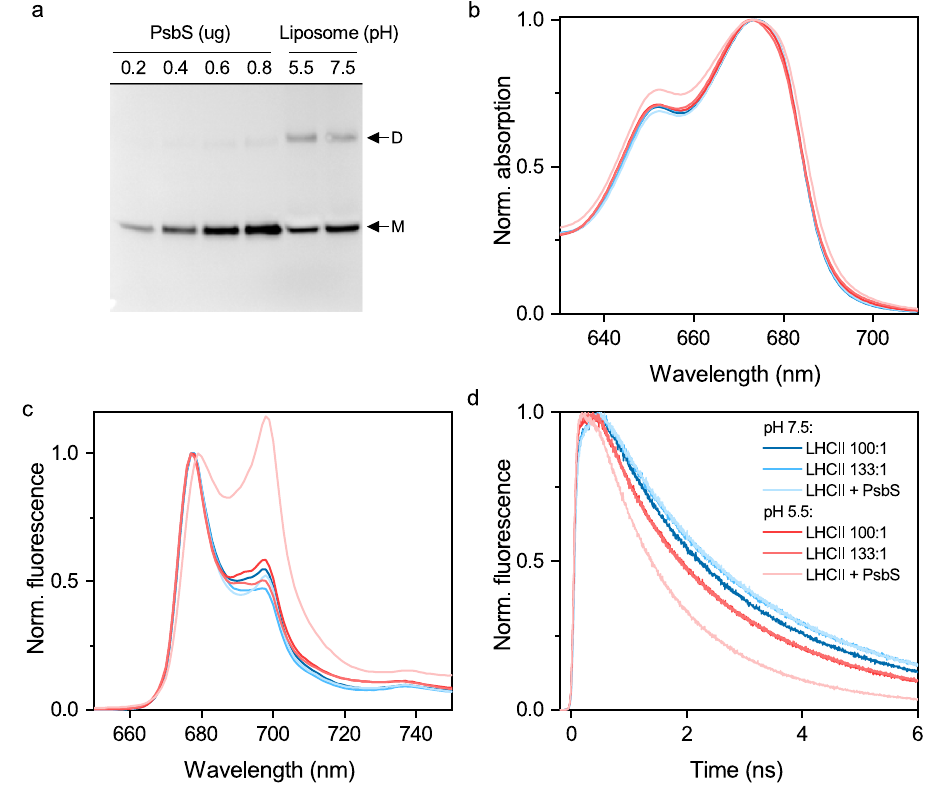
Figure 3. The effect of PsbS on LHCII spectral characteristics in the liposome at pH 7.5 and pH 5.5. ( a ) Immunoblot of PsbS in detergent and in LHCII + PsbS proteoliposomes where M and D denote the monomeric and dimeric forms of PsbS, respectively. The full-length blot is presented in Supplementary Figure S4. ( b ) Absorption spectra normalized to the Q y maximum ( c ) 77 K fluorescence spectra upon excitation at 440 nm, normalized to the maximum. ( d ) Fluorescence decay traces upon excitation at 468 nm and detection at 680 nm. LHCII-only proteoliposome preparations have lipid:protein ratios of 100:1 and 133:1. LHCII + PsbS proteoliposome preparations have total lipid:protein ratios of 100:1, lipid:LHCII ratios of 133:1 and PsbS:LHCII ratios of 1:3. Results are representative of three independent experiments with similar results, which can be viewed in Supplementary Figure